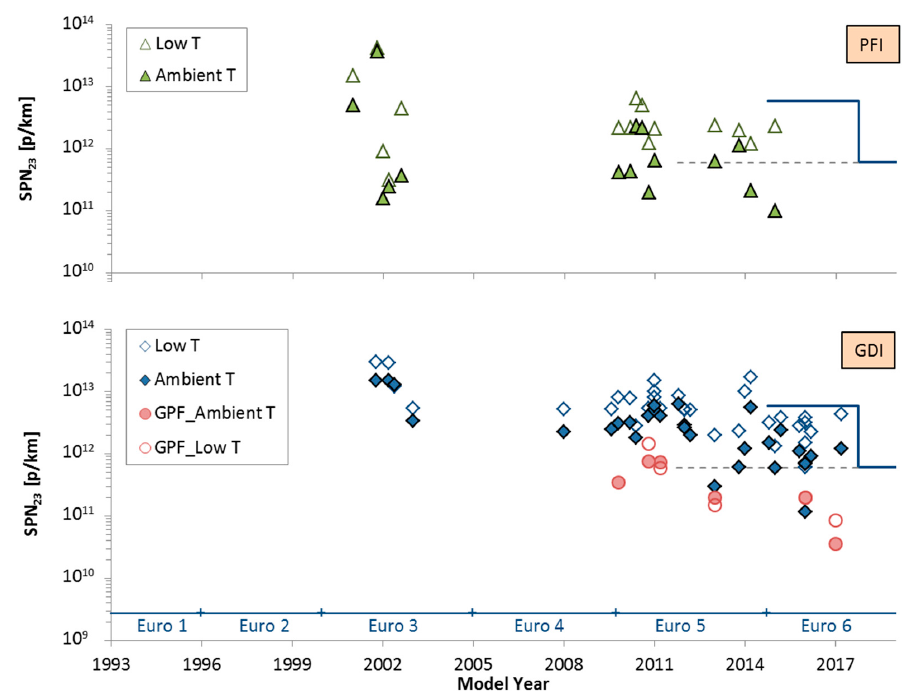
Figure 5. Solid particle number (SPN) emissions for gasoline direct injection (GDI) (lower panel) and port fuel injection (PFI) (upper panel) vehicles at different ambient temperatures. “Ambient T” refers to approximately 23 ° C. “Low T” refers to − 7 ° C. Dashed line shows SPN limit for diesel vehicles at 23 ° C (only EU). Solid line shows SPN limits for GDI vehicles at 23 ° C (only EU).